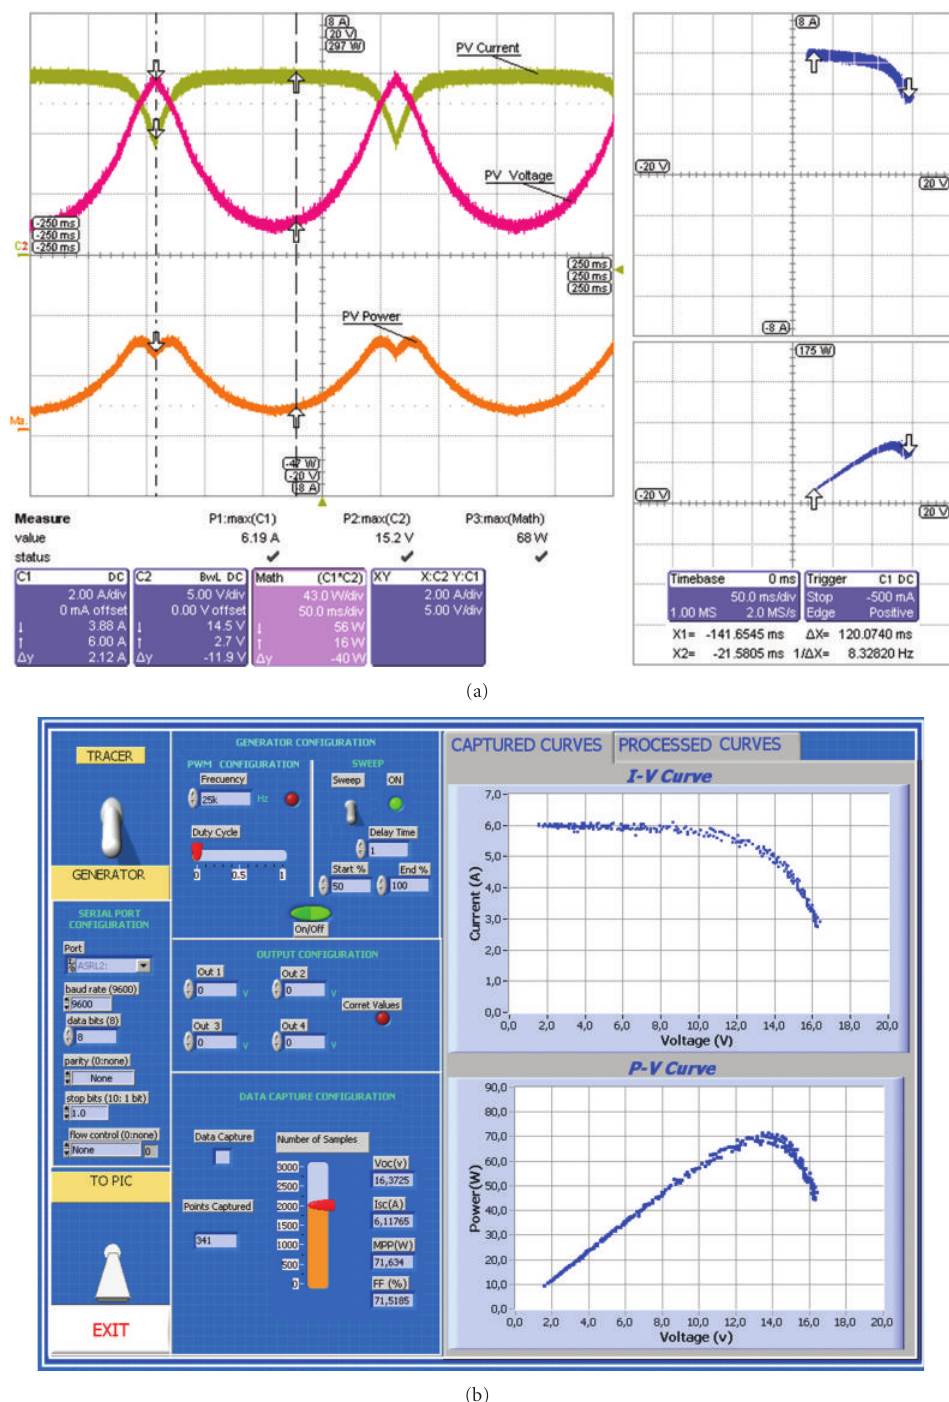
Figure 8: (a) Current (Channel C1: 2 A/div, 50ms/div), voltage (Channel C2: 5 V/div, 50ms/div), and power (Math C1 ∗ C2: 43 W/div, 50ms/div) measurement. XY representation. (b) I-V and P-V curves obtained by means of the proposed system. DCS from 50 to